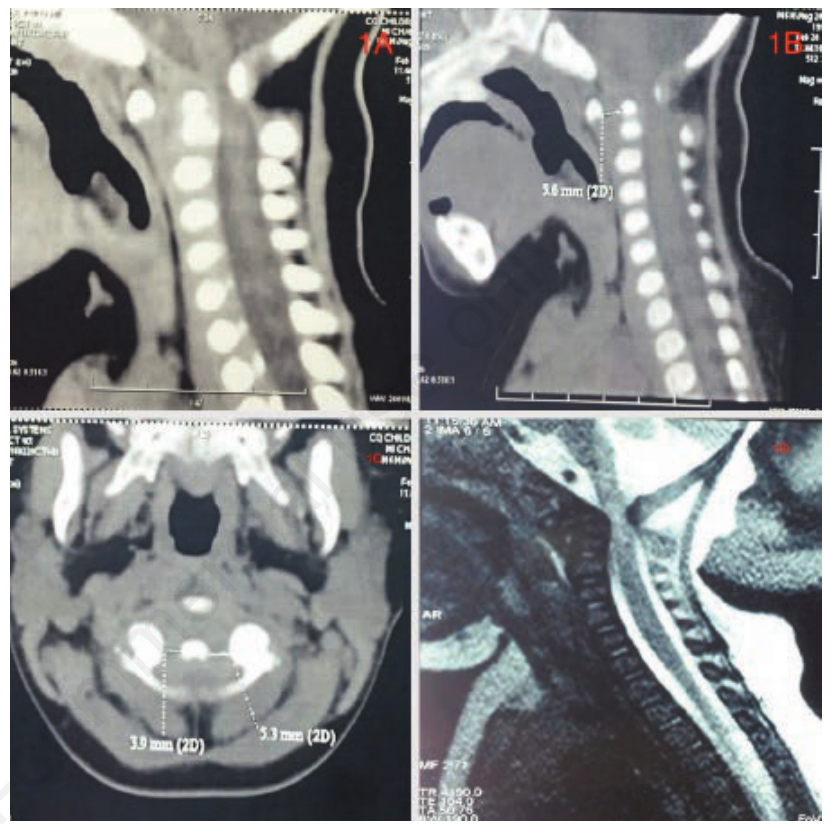
Figure 1. A-D) Are MRI showing the atlantoaxial dislocation with severe cervical spinal cord